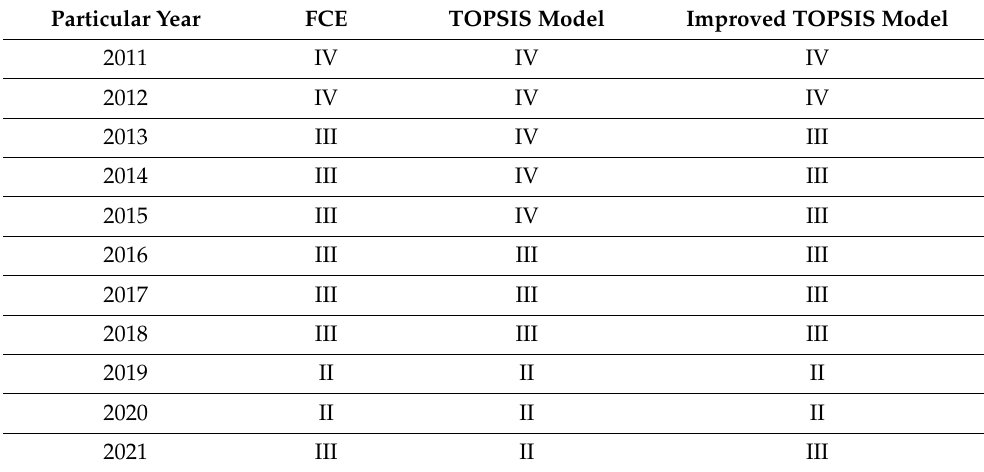
Table 6. Comparison of evaluation